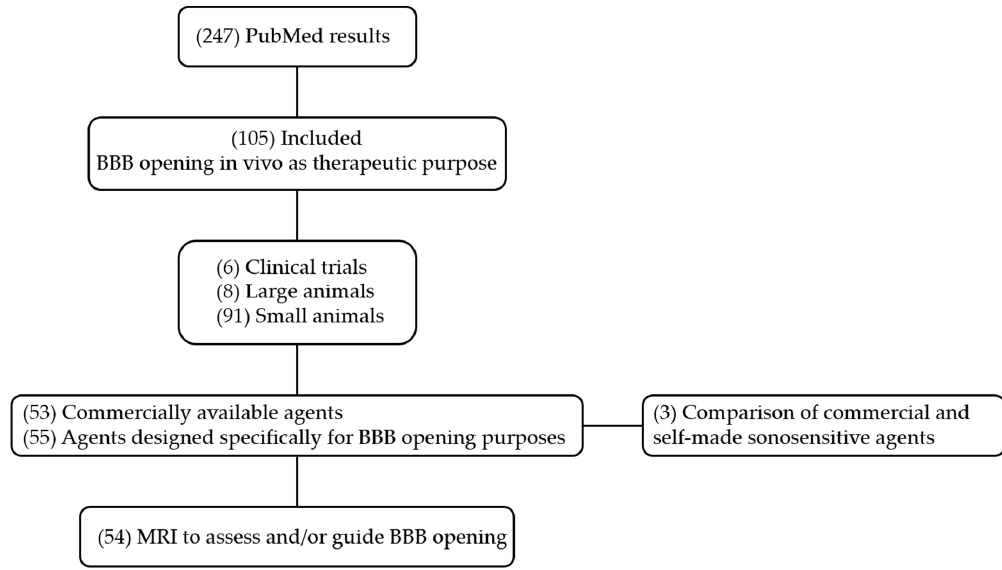
Figure 3. Flow chart of PubMed.